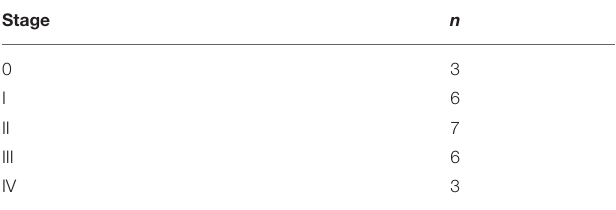
TABLE 4 | Stages of breast cancer diagnosed ( n = 25). TABLE 5 | Patient satisfaction with patient navigation services ( n = 90) *